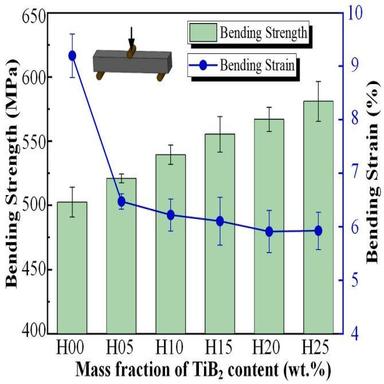
The bending strength and strain of TiB2/Al7050 HC.